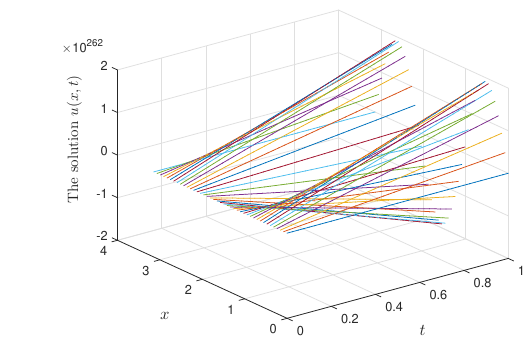
( a ) The source functions Ξ and Ξ ε 1 , ε 2 , ε 3 ( b ) The error estimation between Ξ and Ξ ε 1 , ε 2 , ε 3 α , τ Figure 3. A comparison between Ξ and Ξ ε 1 , ε 2 , ε 3 α , τ for β = 1.5, X = T = 40, { ε 1 , ε 2 , ε 3 } := { 3 × 10 − 1 ,2 × 4 10 − 2 ,5 × 10 − 1 } , τ = 5.